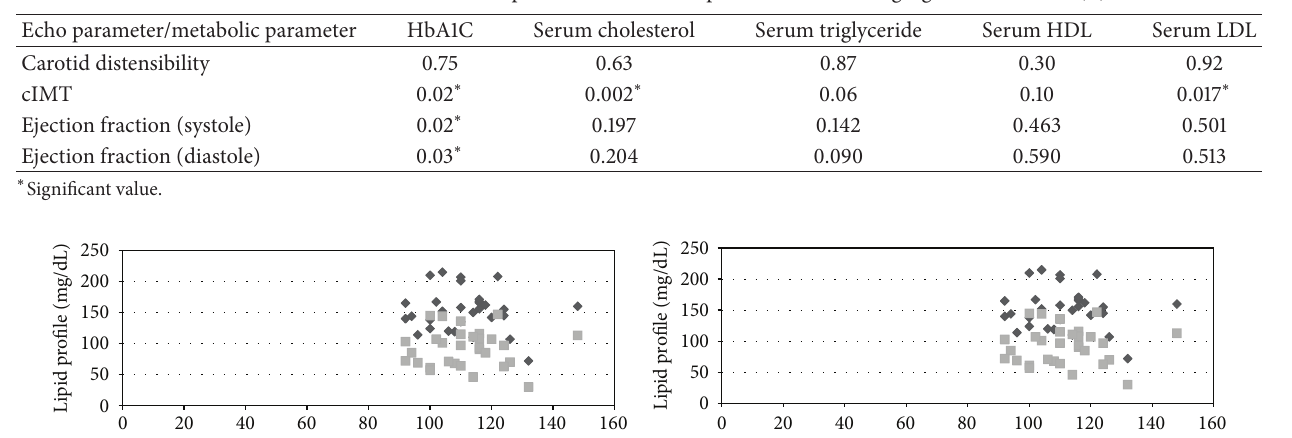
Table 2: Cardiovascular variables compared with metabolic parameters—showing significance values ( 𝑃 ).